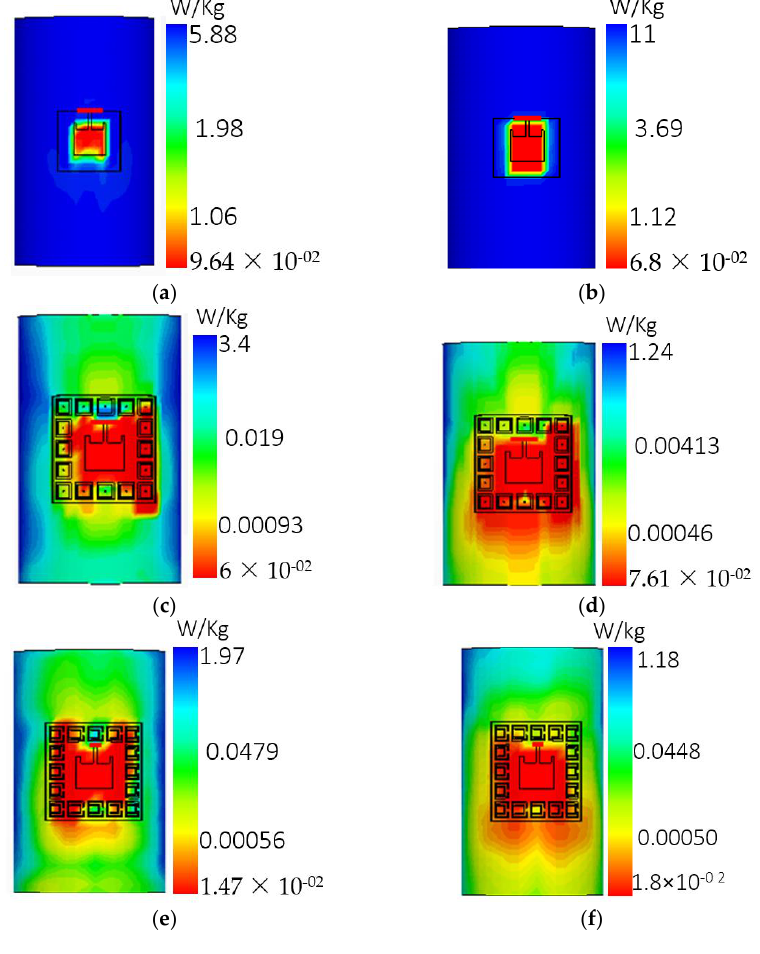
Figure 21. Conventional antenna bent around human arm: ( a ) SAR at 2.4 GHz. ( b ) SAR at 5.4 GHz, EBG-based antenna bent around human arm. ( c ) SAR at 2.4 GHz. ( d ) SAR at 5.4 GHz, SRR-based antenna bent around human arm. ( e ) SAR at 2.4 GHz. ( f ) SAR at 5.4